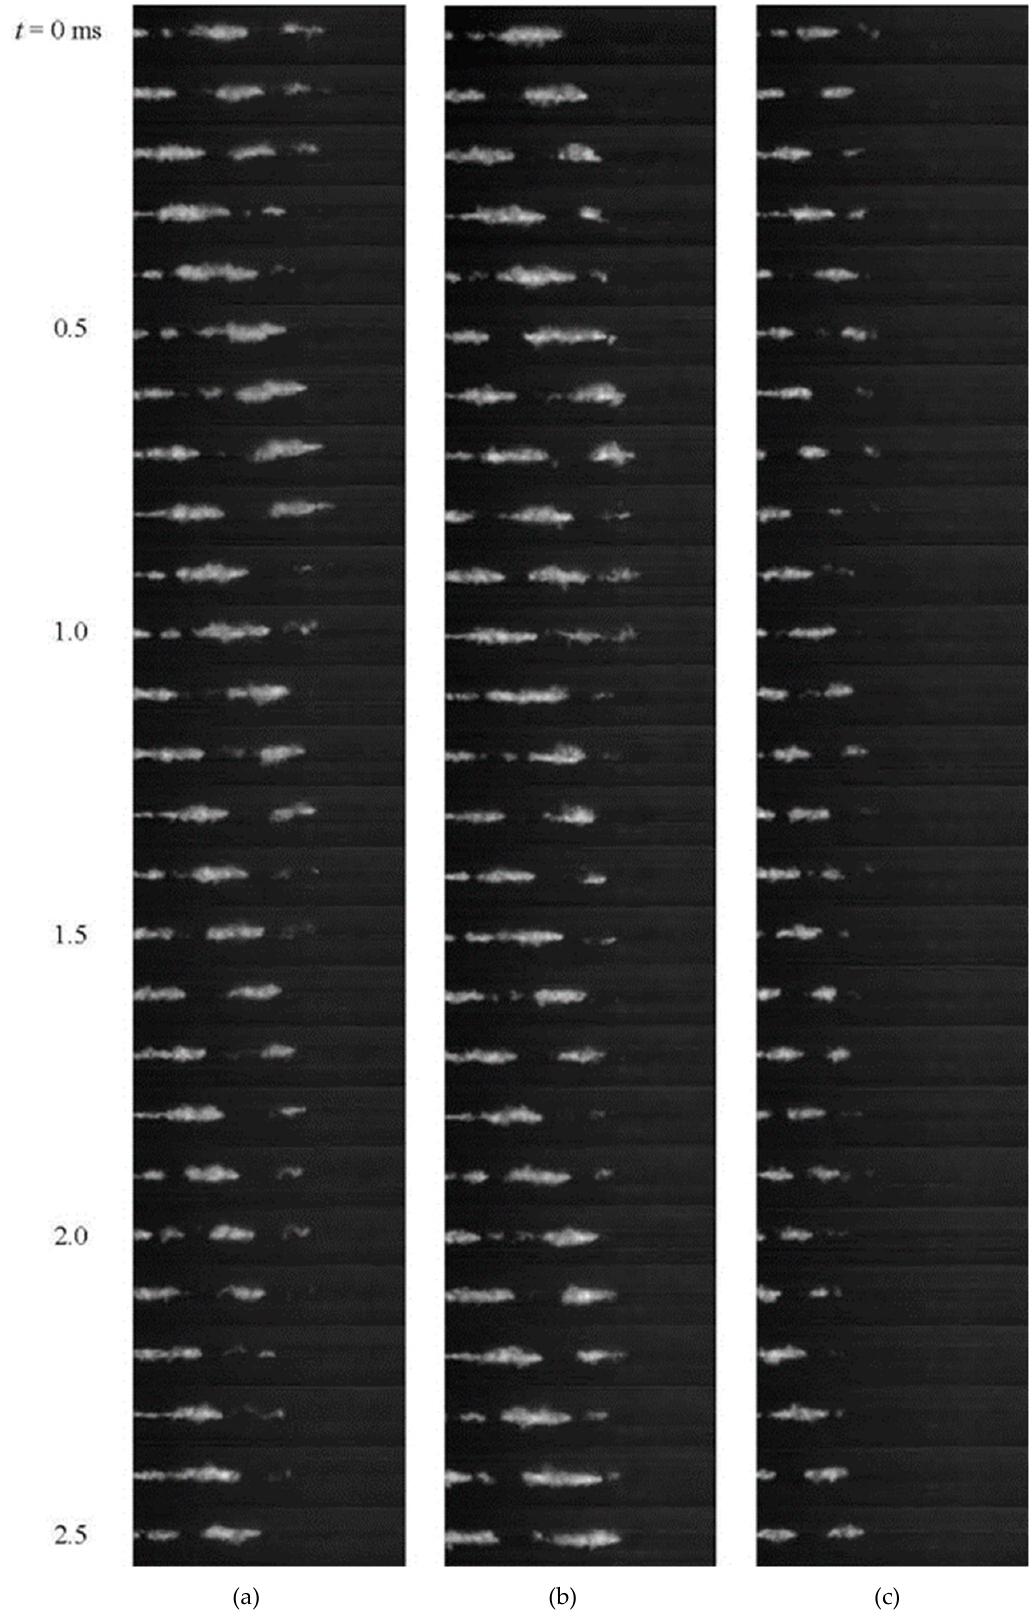
Figure 11. Aspects of periodical shedding of cloud cavitation: ( a ) p 1 = 20 MPa, σ = 0.014; ( b ) p 1 = 30 MPa, σ = 0.014; ( c ) p 1 = 20 MPa, σ = 0.02 [21].